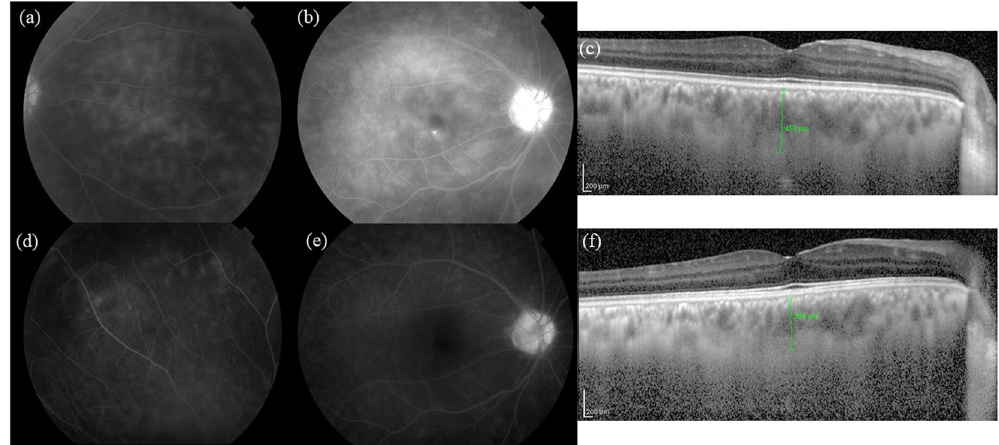
Figure 3. Fluorescein angiography (FA) and enhanced depth imaging optical coherence tomography (EDI- OCT) images of the active and convalescent phases in a representative eye with Behçet’s disease. In the active phase, FA reveals dense retinal vascular leakage in all retinal locations (peripheral retina ( a ), macula ( b ), and optic disc ( b )), and the subfoveal choroidal thickness (SCT) was determined to be 453 μ m ( c ). In the convalescent phase, the retinal vascular leakage improved in all parts ( d , e ), while the SCT was decreased at 364 μ m ( f